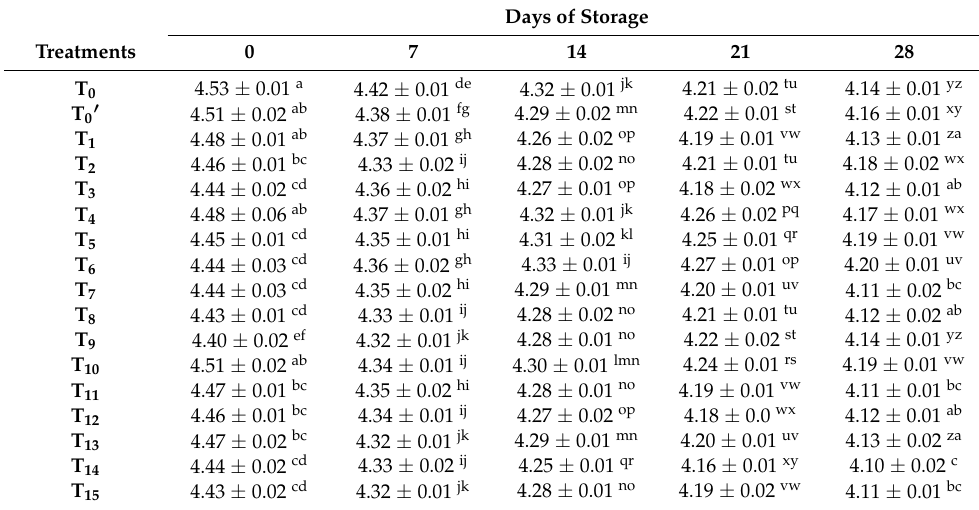
Table 4. Effect of guar gum and storage time on the pH of probiotic